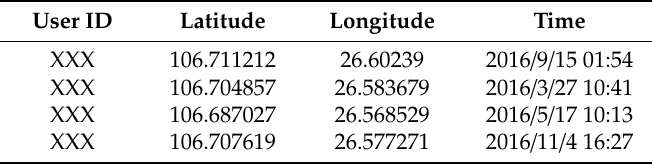
Table 1. Samples of Sina Weibo check-in data after data collection.